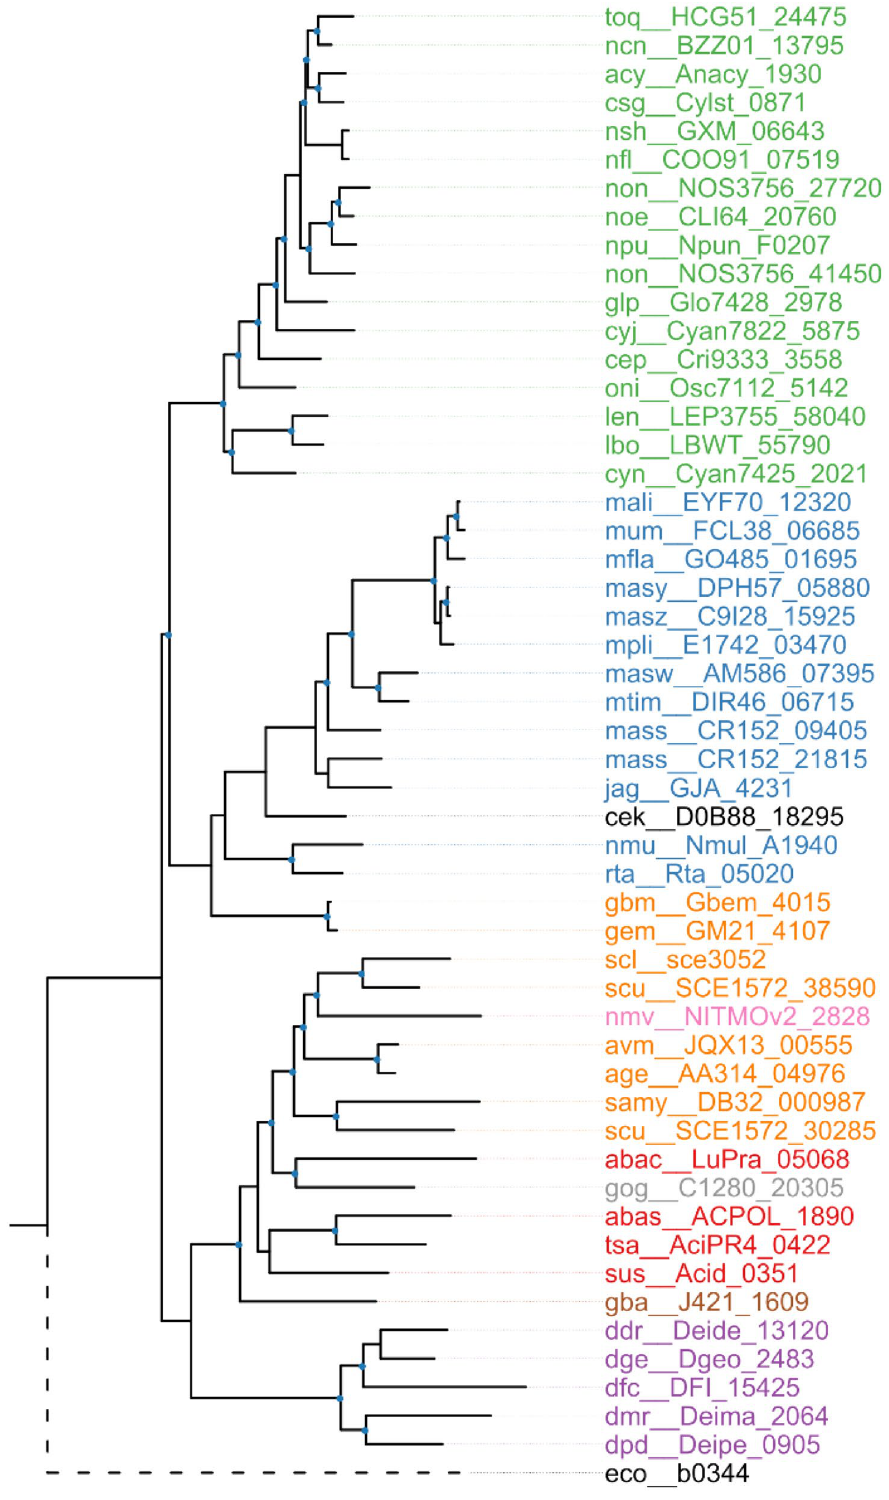
Figure 1. Phylogenetic analysis of Nf-LacZ (COO91_07519) with its top 50 similar homologs from the KEGG database. The nodes with bootstrap values higher than 70% were highlighted with blue dots. The lacZ homologs from Cyanobacteria (green) form a distinct clade. The homologs from Betaproteobacteria were highlighted in blue, the homologs from Deltaproteobacteria were highlighted in orange, the homologs from Acidobacteria were highlighted in red, and the homologs from Deinococcus-Thermus group were highlighted in purple. The species names for these proteins were included in supplemental table